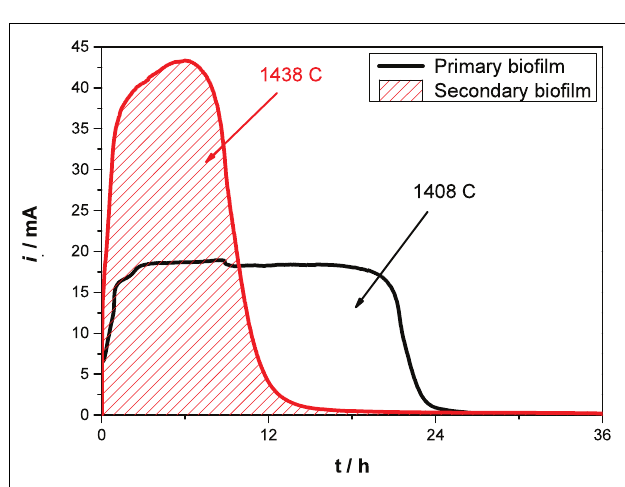
FIGURE 4 |An example showing the comparison of the cycle duration of a primary (black) and secondary biofilm (red) .The amount of charge transferred during the bioelectrocatalytic substrate oxidation is indicated by the curves’